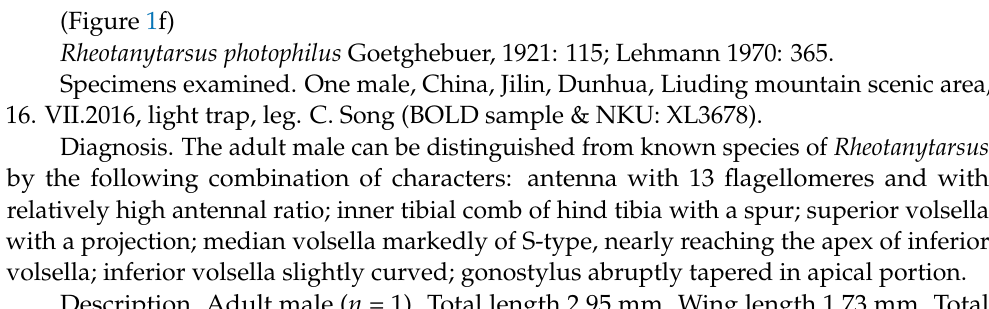
length/wing length 1.71 Wing length/length of profemur